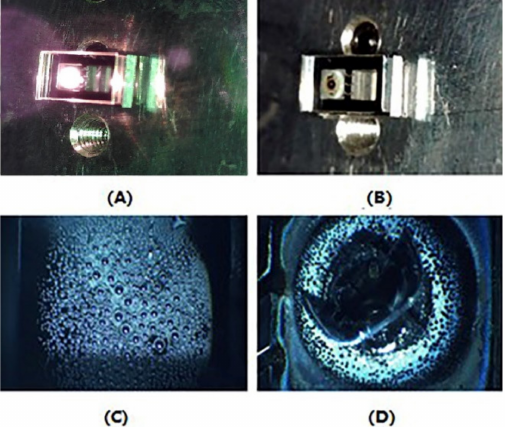
Figure 4. ( A )The activating system with a 808 nm diode laser source; ( B , D ) the vapor cell after activating by laser; and ( C ) the Rb elemental on the inner-surface of the optical